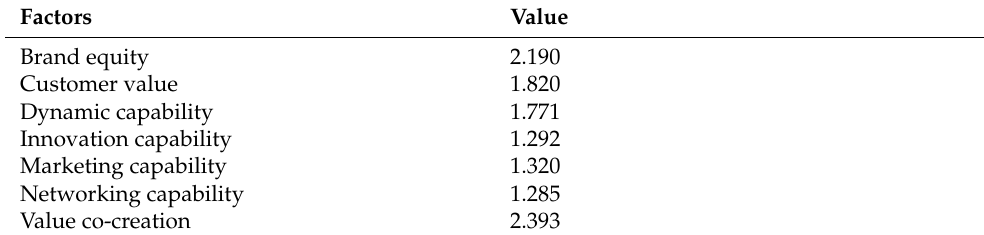
Table 5. Full collinearity